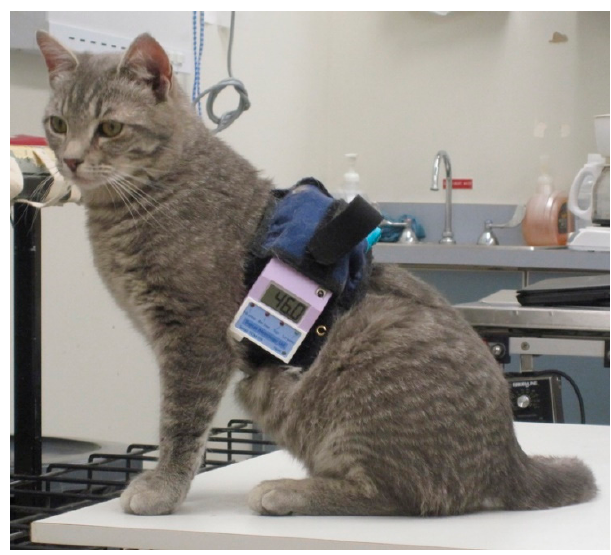
Figure 1. Remote controlled thermal unit worn by a small cat (3 kg) free roaming in a room.